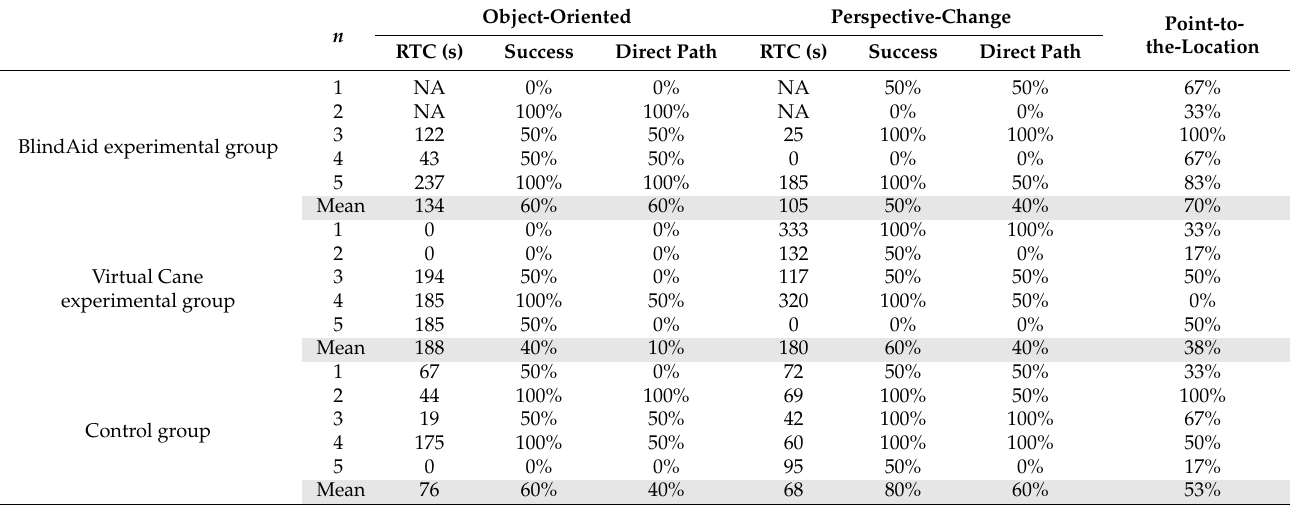
Table 7. Success in orientation tasks in complex